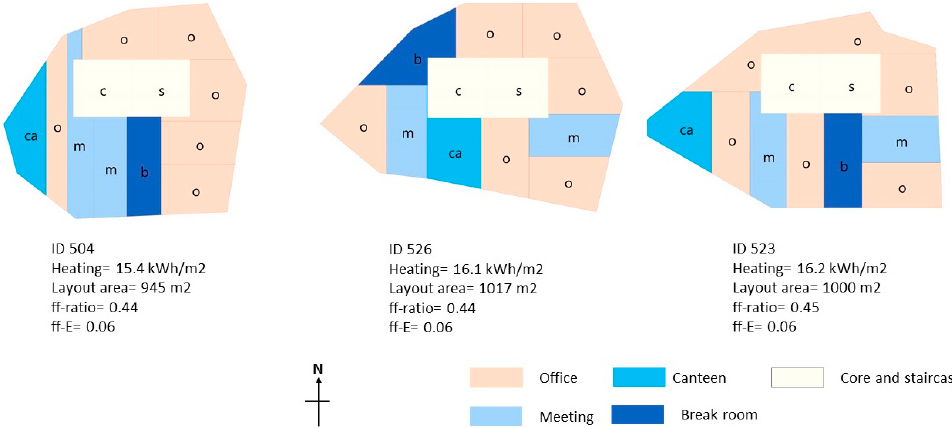
Figure 9. Layouts with no room orienting West, resulting from the optimisation for minimising heating demand. Note: The room orientations were defined based on the normal of internal walls.